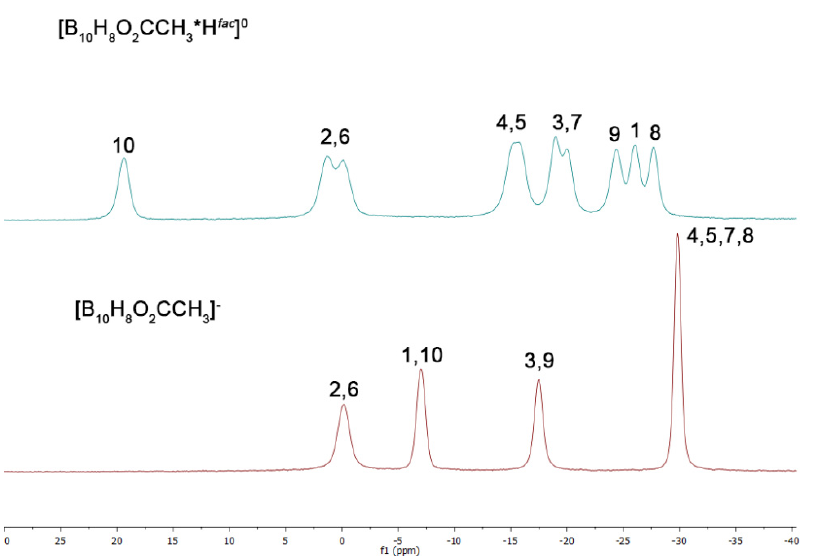
Figure 5. 11 B- 1 H NMR spectra of [B 10 H 8 O 2 CCH 3 ] − ( bottom ) and [B 10 H 8 O 2 CCH 3 *H fac ] 0 ( top ). The numbers are the positions of the boron atoms in the cluster polyhedral.